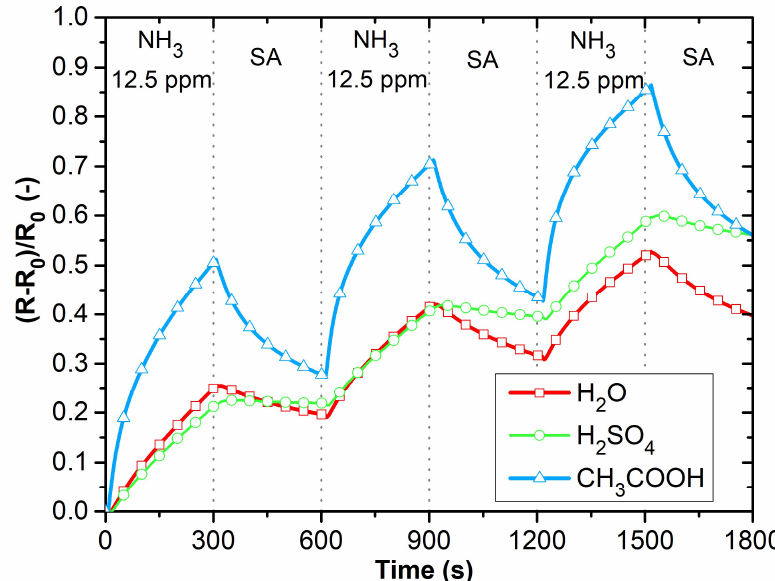
Figure 14. Gas characterization of active layers toward 12.5 ppm of ammonia.